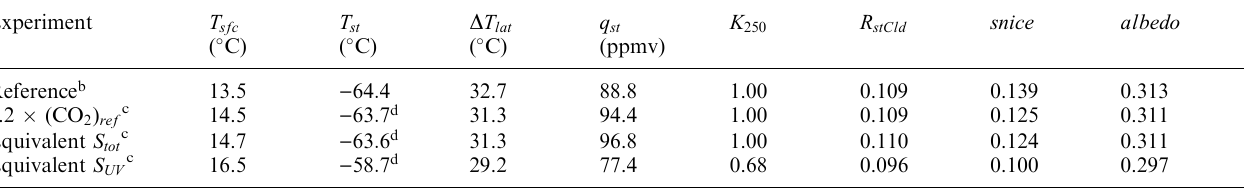
Table 1. Annual-mean parameters: a intercomparison of responses of CO 2 , S tot and S UV forcings